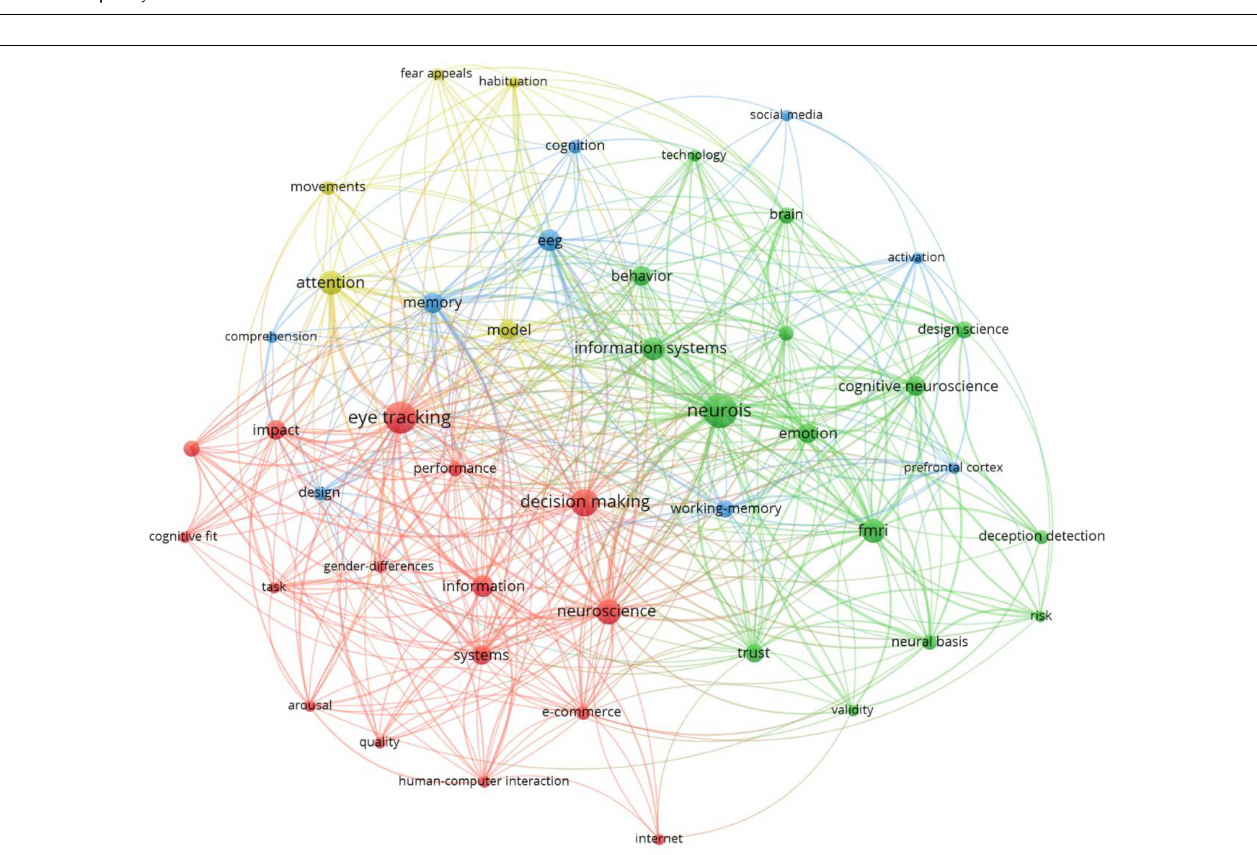
FIGURE 7 | The Top 23 keywords with the strongest citation bursts from 2010 to 2021.